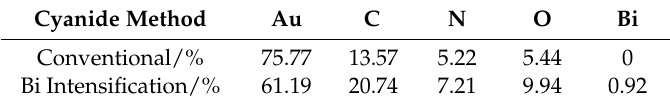
Figure 7. XPS full spectrum of gold surface products in Bi intensification cyanide system. Table 2. Relative concentration of elements on cyanided gold surface products.